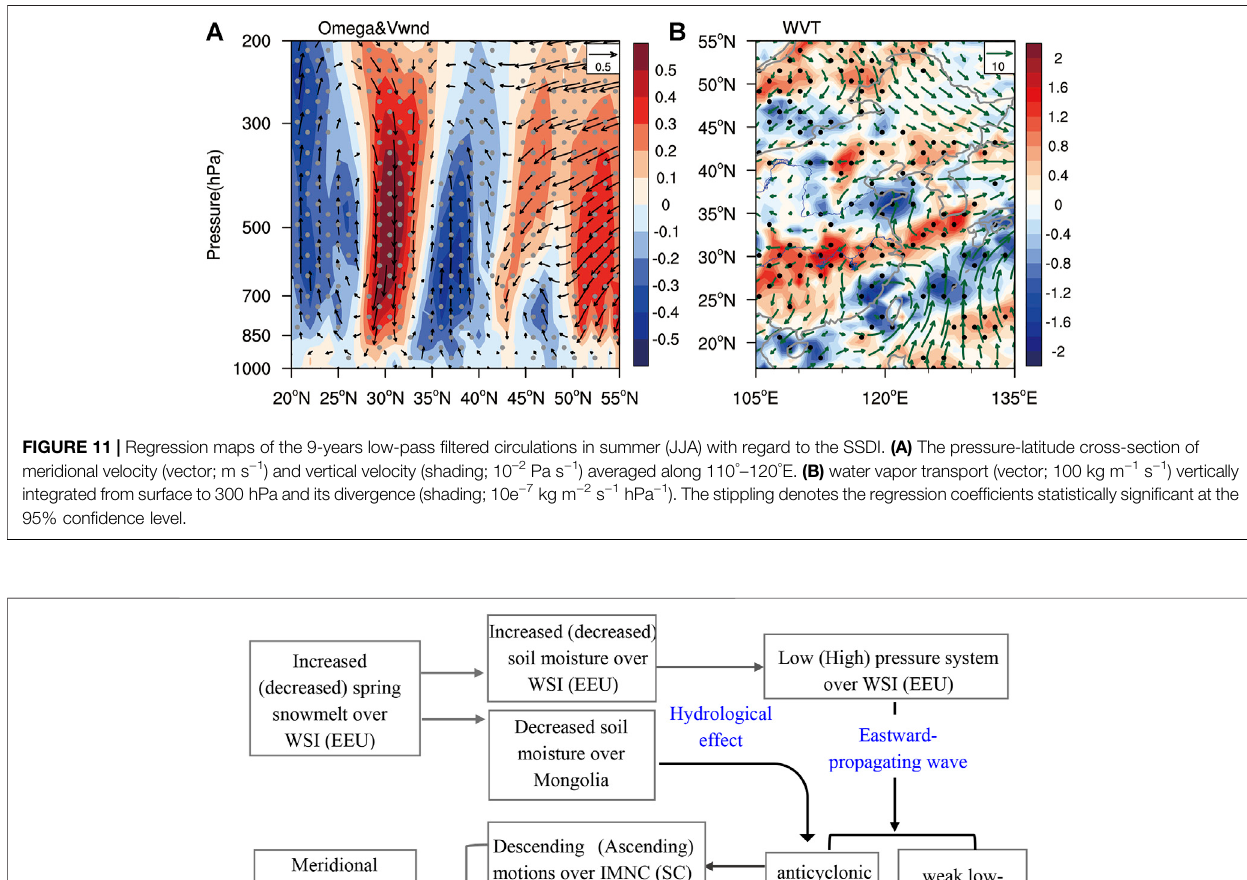
Frontiers in Earth Science |